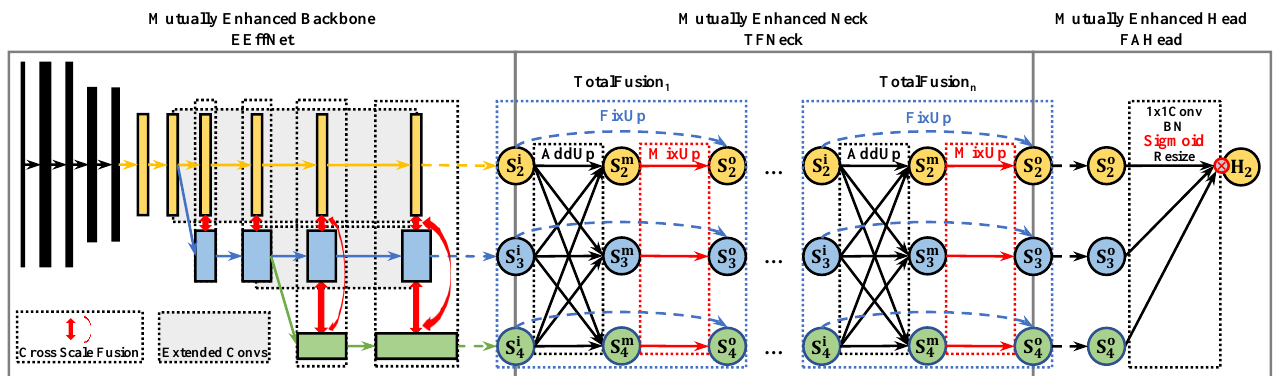
Figure 2. An overview of our MEMe-based pose net, efficient and effective pose (EEffPose). Our EEffPose contains three modules: enhanced EfficientNet (EEffNet), total fusion neck (TFNeck) and final attention head (FAHead). In figure, S j means the j-th scale feature in the feature pyramid. In particular, H 2 represents the heatmap output with the size of a quarter of the